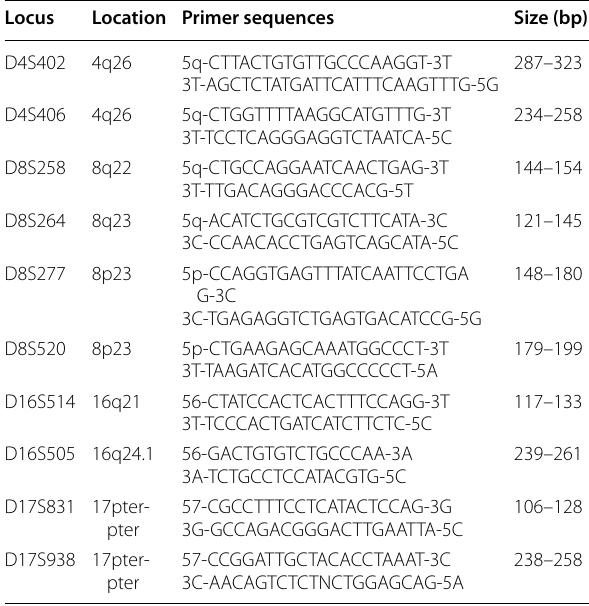
Table 1 Primers and characteristics of microsatellite mark- ers Locus Location Primer